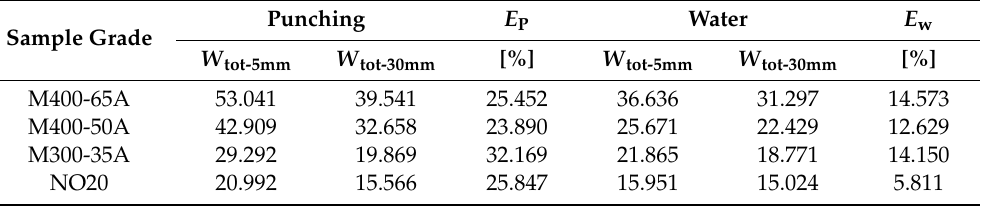
Figure 12. Total energy loss versus frequency dependencies of electrical steel grade NO20 ( a ) and M300-35A ( b ), in the case of two cutting technologies. Table 3. Total energy loss W tot [mJ/kg] at frequency f = 50 Hz and magnetic polarization J p = 1 T for two different widths w = 5, 30 mm.